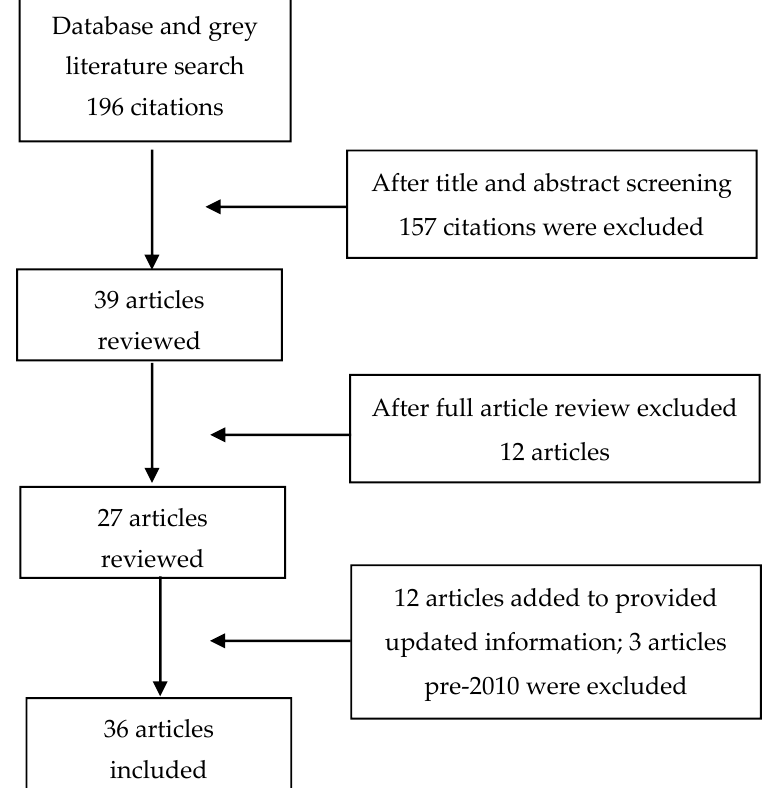
Figure 1. PRISMA flow diagram of articles included in the review.